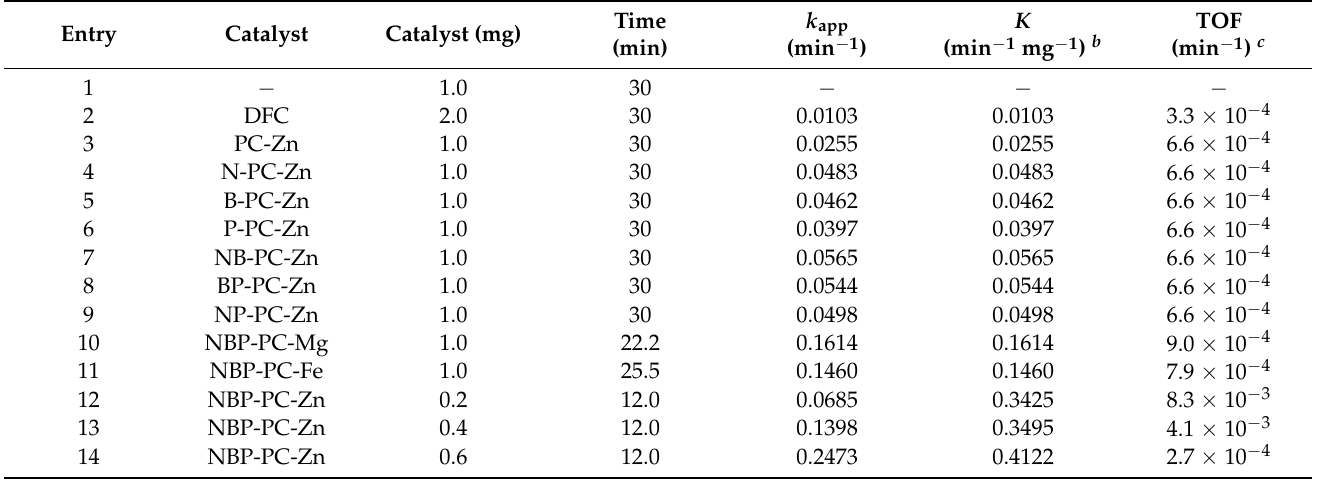
Table 2. Comparison of the MB dye reduction performances of as-prepared carbon catalysts a